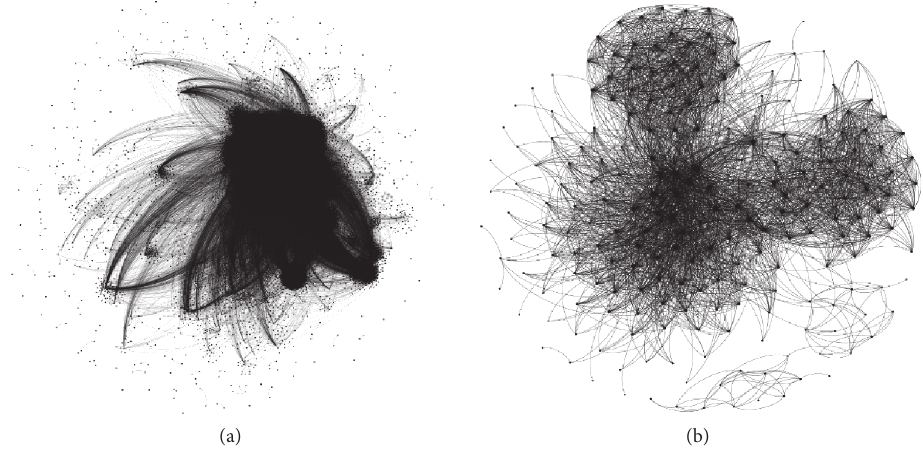
Figure 4: The two-layered network model applied to Huawei P10/P10 Plus: (a) FIR network; (b) FII